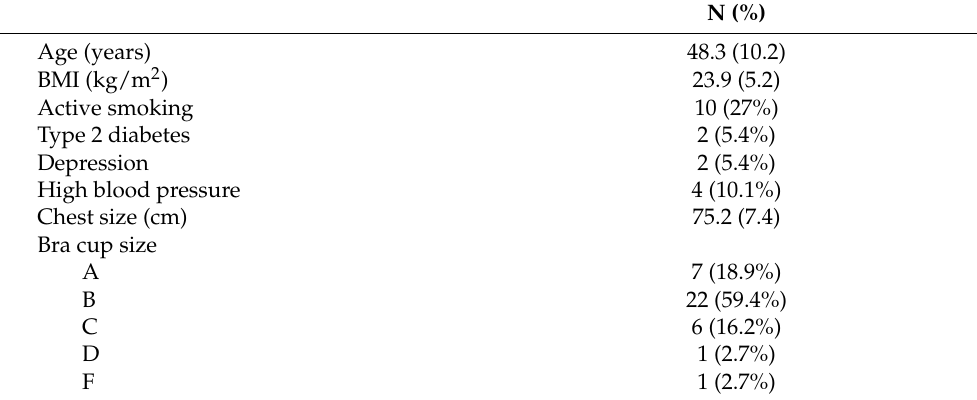
Table 1. General characteristics of the study population ( n = 37).